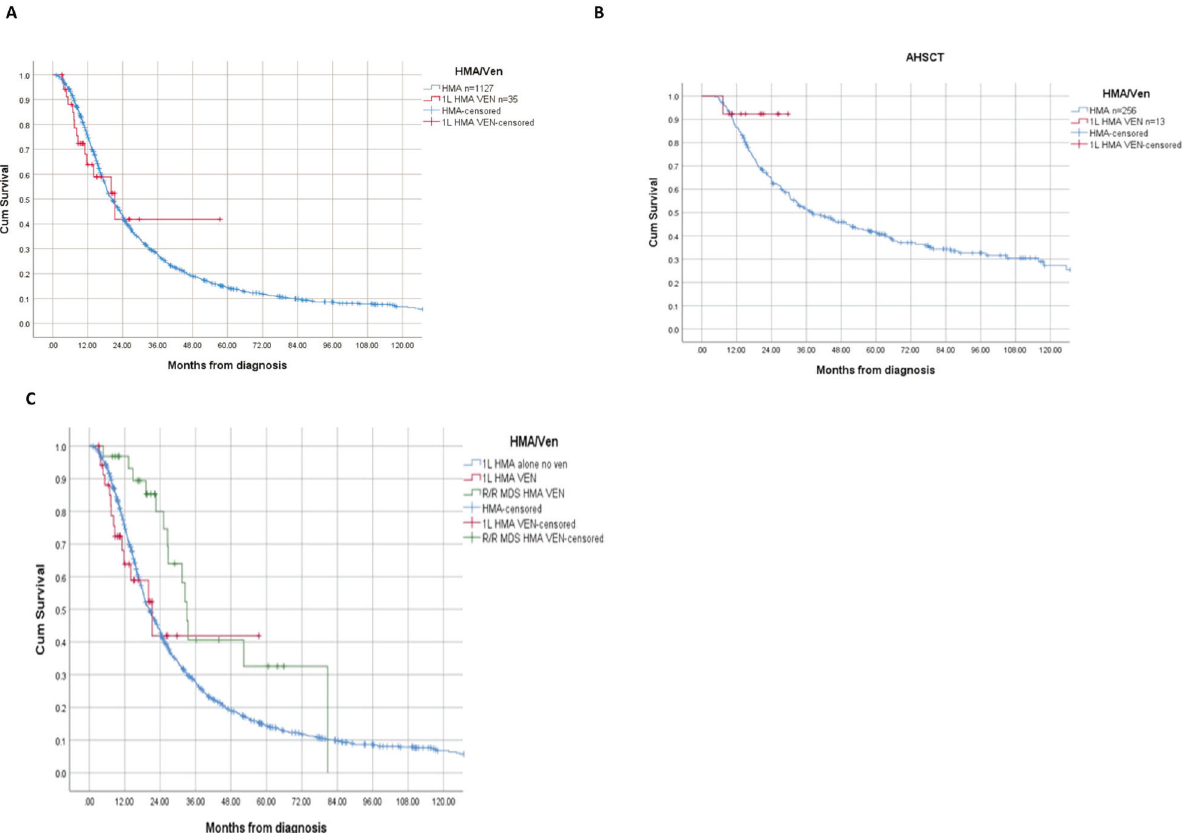
Fig. 1 Kaplan Meier estimates of overall survival. A Overall survival in fi rst-line HMA vs. HMA/Ven. B Overall survival among AHSCT cohort based on upfront therapy. C Overall survival in HMA/Ven in relapsed/refractory MDS after fi rst-line